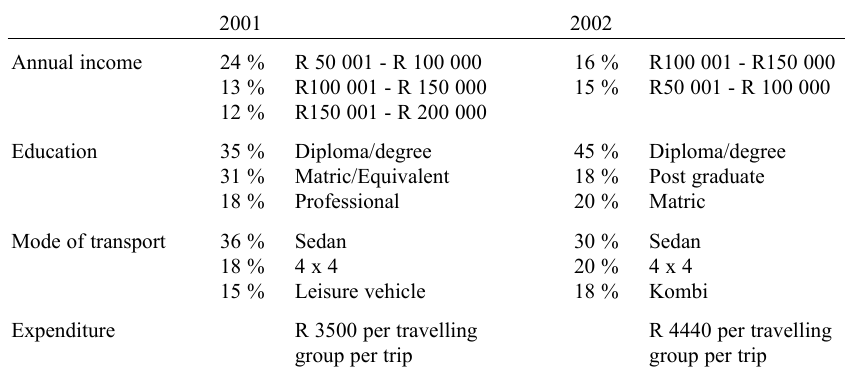
Socio-economic profile